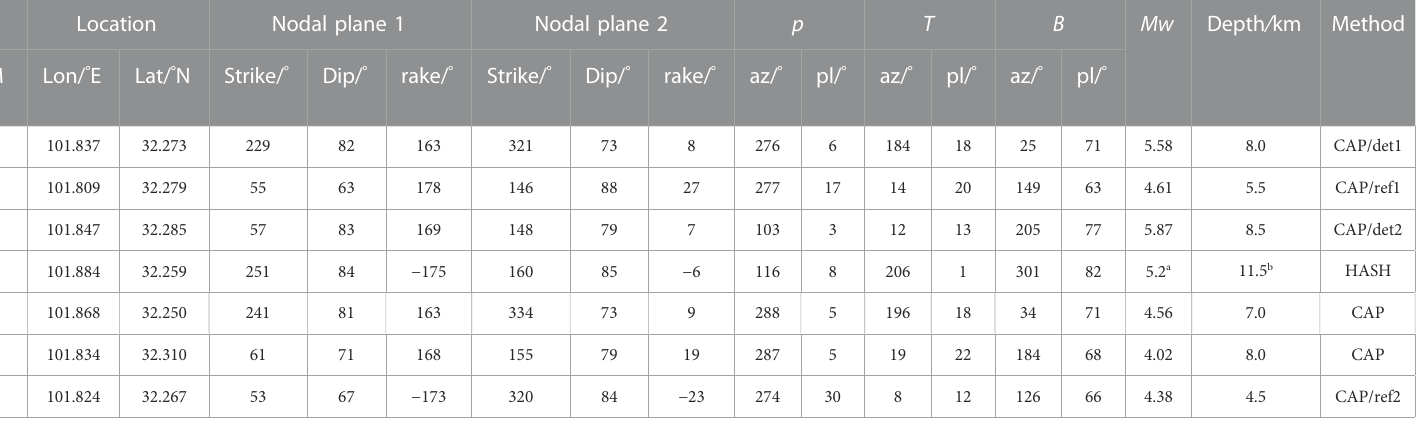
TABLE 3 Focal mechanism solutions for the maerkang earthquake